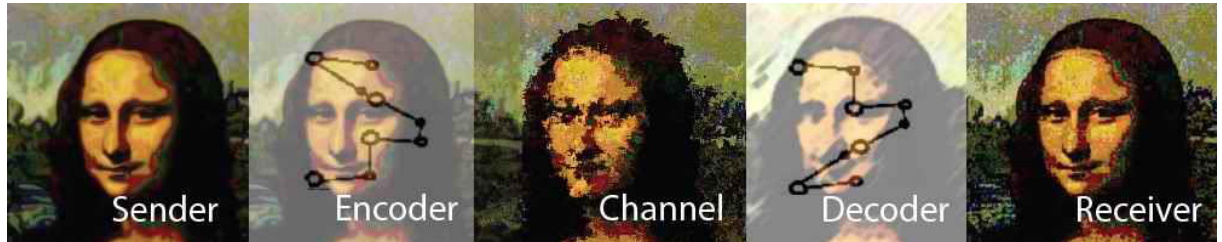
Fig. 6 : The artistic process and Shannon’s Theory of Communication